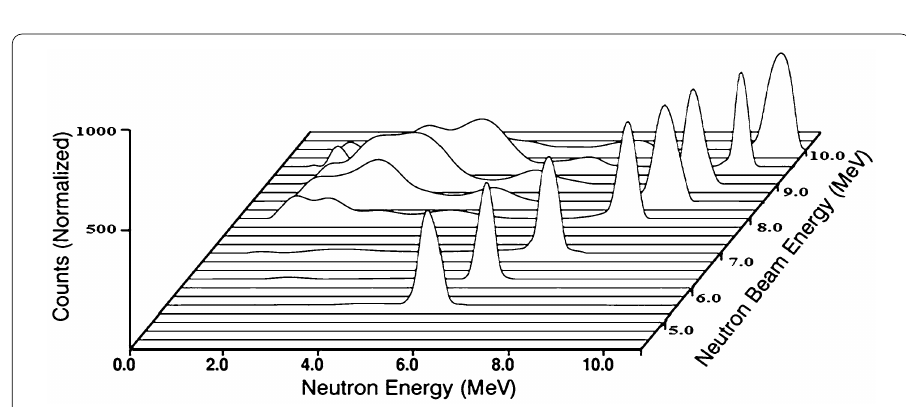
Figure 3 The energy distribution of the neutron flux from the 2 H(d,n) reaction deduced via the DIFBAS